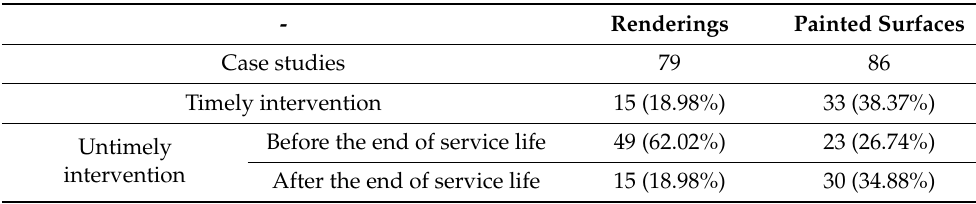
Table 5. Summary of the timing of the intervention in relation to the service life of the painted